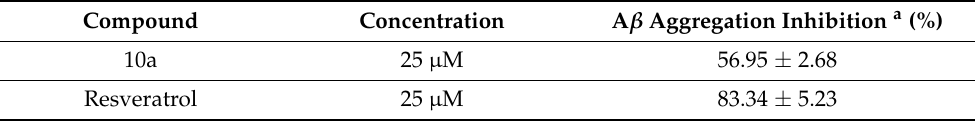
Table 3. The A β aggregation inhibition of compound 10a and control